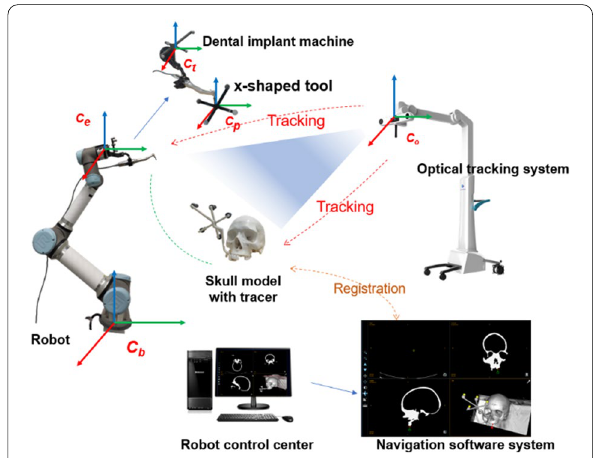
Figure 1 Illusion of the dental implant robot system